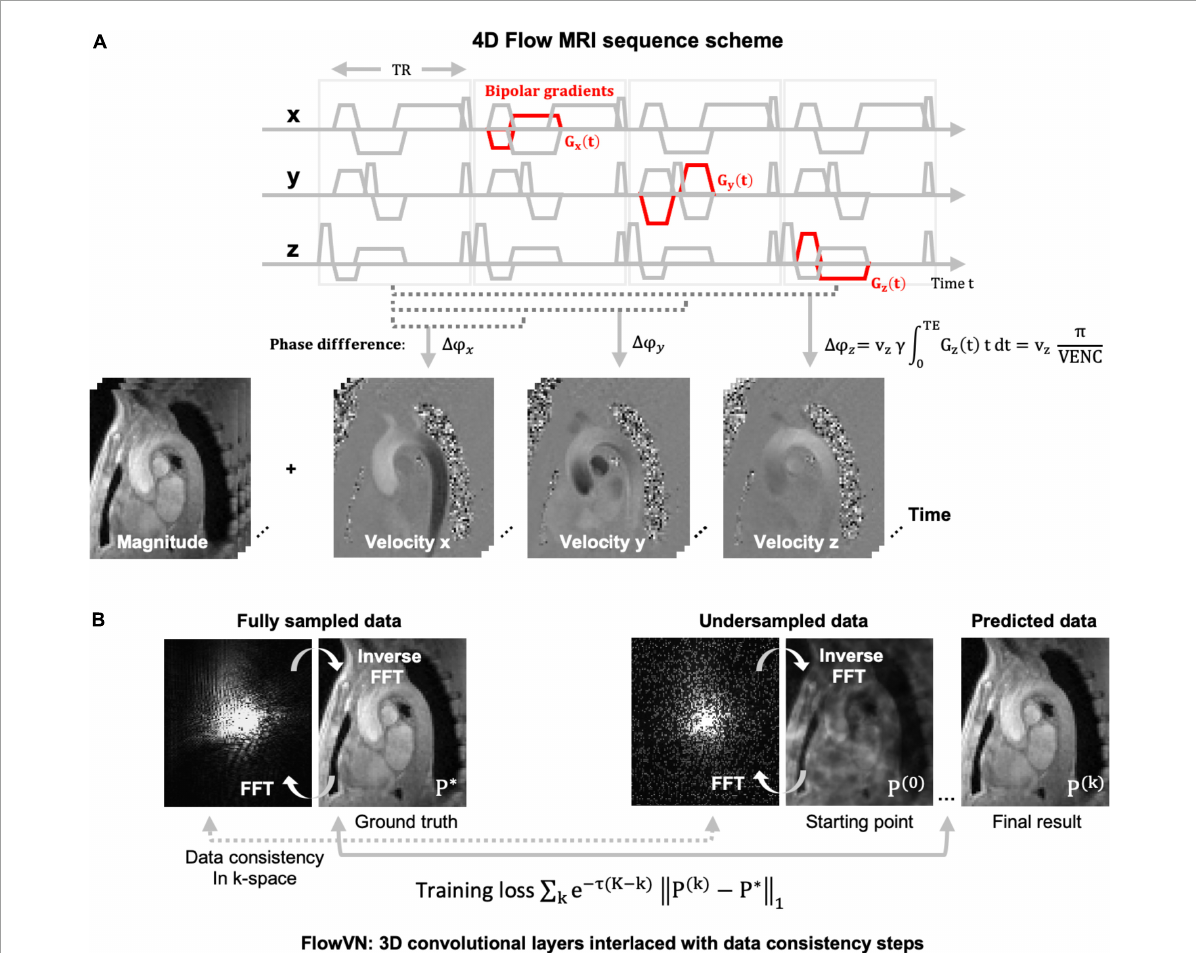
FIGURE1 (A) 4D flow MRI image acquisition scheme using a spoiled gradient echo sequence with additional bipolar gradients for motion encoding (red). The velocity maps of this exemplary 4D flow MRI dataset of the aortic arch are obtained by subtracting the phase φ of the reference and the three flow encoded images. Magnitude images for the four acquired images are averaged, or in other applications, used for turbulence encoding. All images are time-resolved, representing one cardiac cycle. The velocity encoding strength (VENC) in [cm/s] is set by the user and is inversely proportional to the area of the bipolar gradient. The VENC is usually chosen in the range of the maximum expected velocity to prevent velocity aliasing. (B) Fully sampled and randomly undersampled k-space and their corresponding images. The undersampled data displays incoherent artefacts in image space (P ( 0 ) ). In data recovery training with the FlowVN (28). P ( 0 ) is the Fourier transform of the undersampled k-space and the starting point of the training. The training loss is defined by the difference of the reconstructed image with the fully sampled data (P*). The data consistency is calculated in k-space as the difference between the sampled datapoints. After k iterations image P ( k ) is achieved. Abbreviations: TR = repetition time, TE = echo time, x,y,z = spatial dimension, v = velocity, γ = gyromagnetic ratio, FFT = fast Fourier transform, P = image, k = iteration